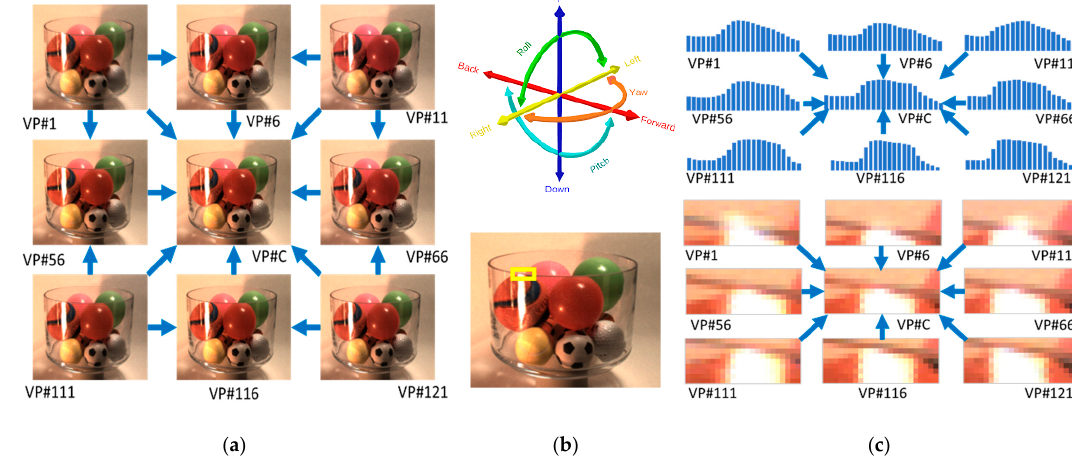
Figure 5. Scene flows in light field (LF) imagery: ( a ) views of positional and directional movements corresponding to central viewpoint; ( b ) each pixel in LF imagery has six degrees of freedom, with region of interest (ROI) indicated by yellow rectangle; and ( c ) example of ROI displacement and corresponding intensity plot.